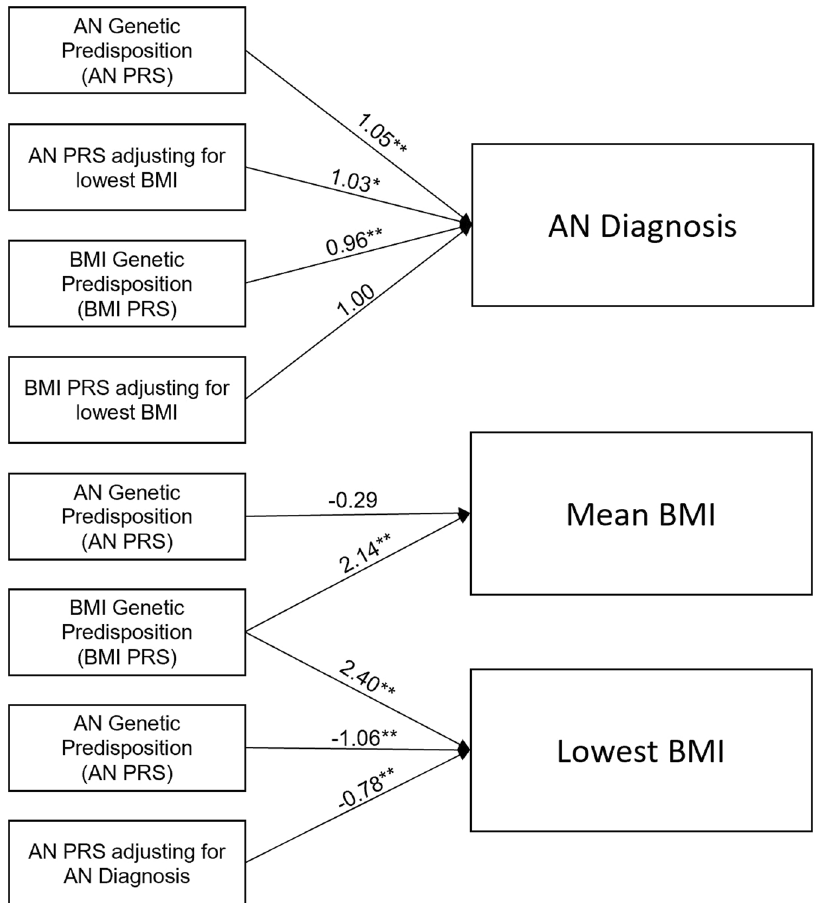
Fig. 1 Schematic representation of the associations tested. Arrows between boxes denote associations tested. Beta values and signi fi cance (** p < 6.25 × 10 − 3 ) (* p < 0.05) are reported for associations with mean/lowest BMI, while odds ratios and signi fi cance are reported for associations with AN